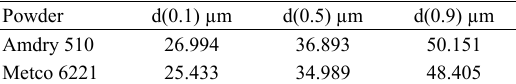
Table 3. Particle size distribution of Amdry 510 and Metco 6221 powders.